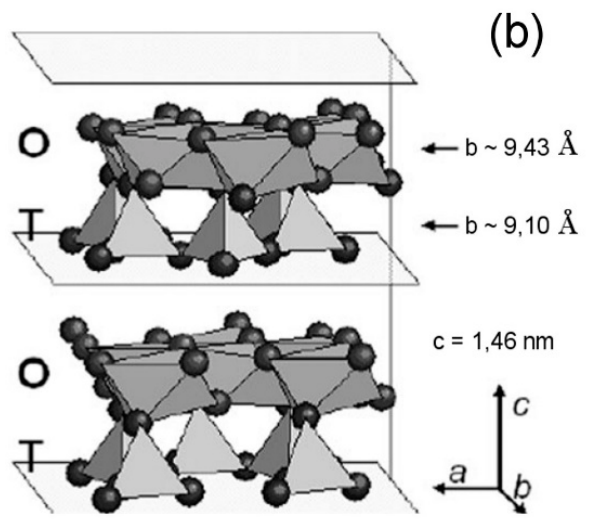
Figure 16. ( a ) Scheme 1 of the chrysotile hollow tube structure: 85 × 53 mm (300 × 300 DPI) [130]; ( b ) lattice of chrysotile (Scheme 2 [135]).